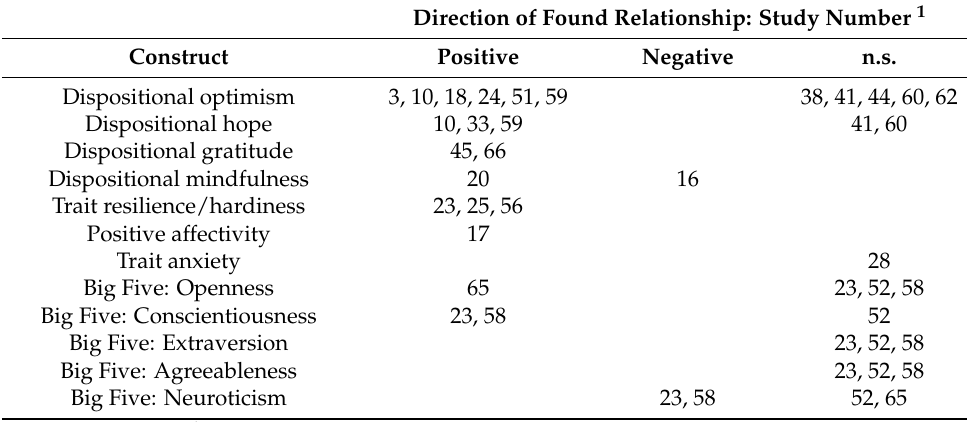
Table 4. Relationships of different personality traits with the PTGI total